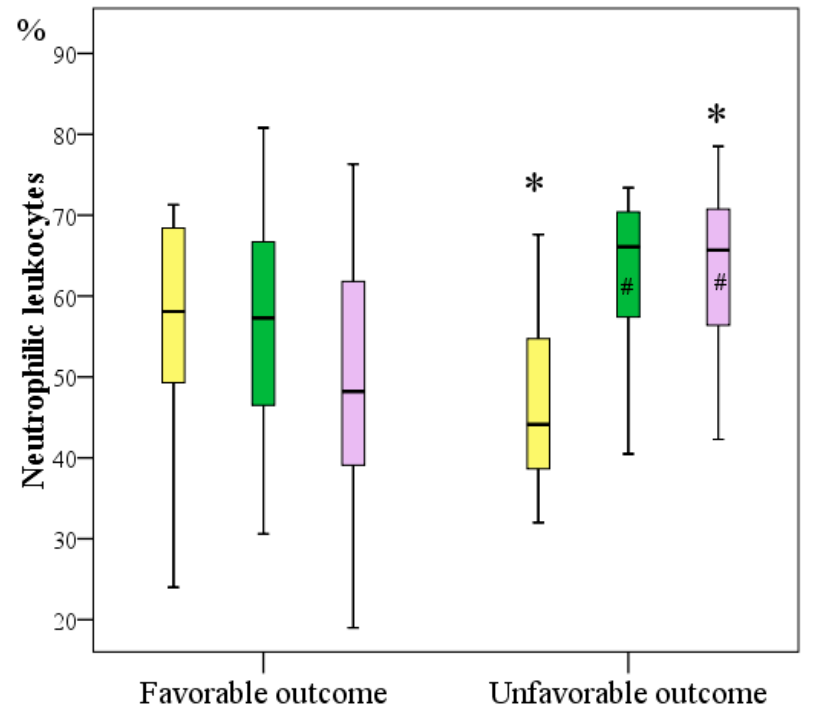
Figure 5. Frequency of occurrence of neutrophilic leukocytes in chronic diabetic foot wounds in patients with different outcomes on Day 1 during primary surgical treatment (*—difference between groups in terms of outcome at p < 0.05, Mann–Whitney U test; #—a significant increase in the number of cells relative to their content in the centre of the wounds within one outcome subgroup at p < 0.05, Friedman test). of the wounds (r = 0.462; p <